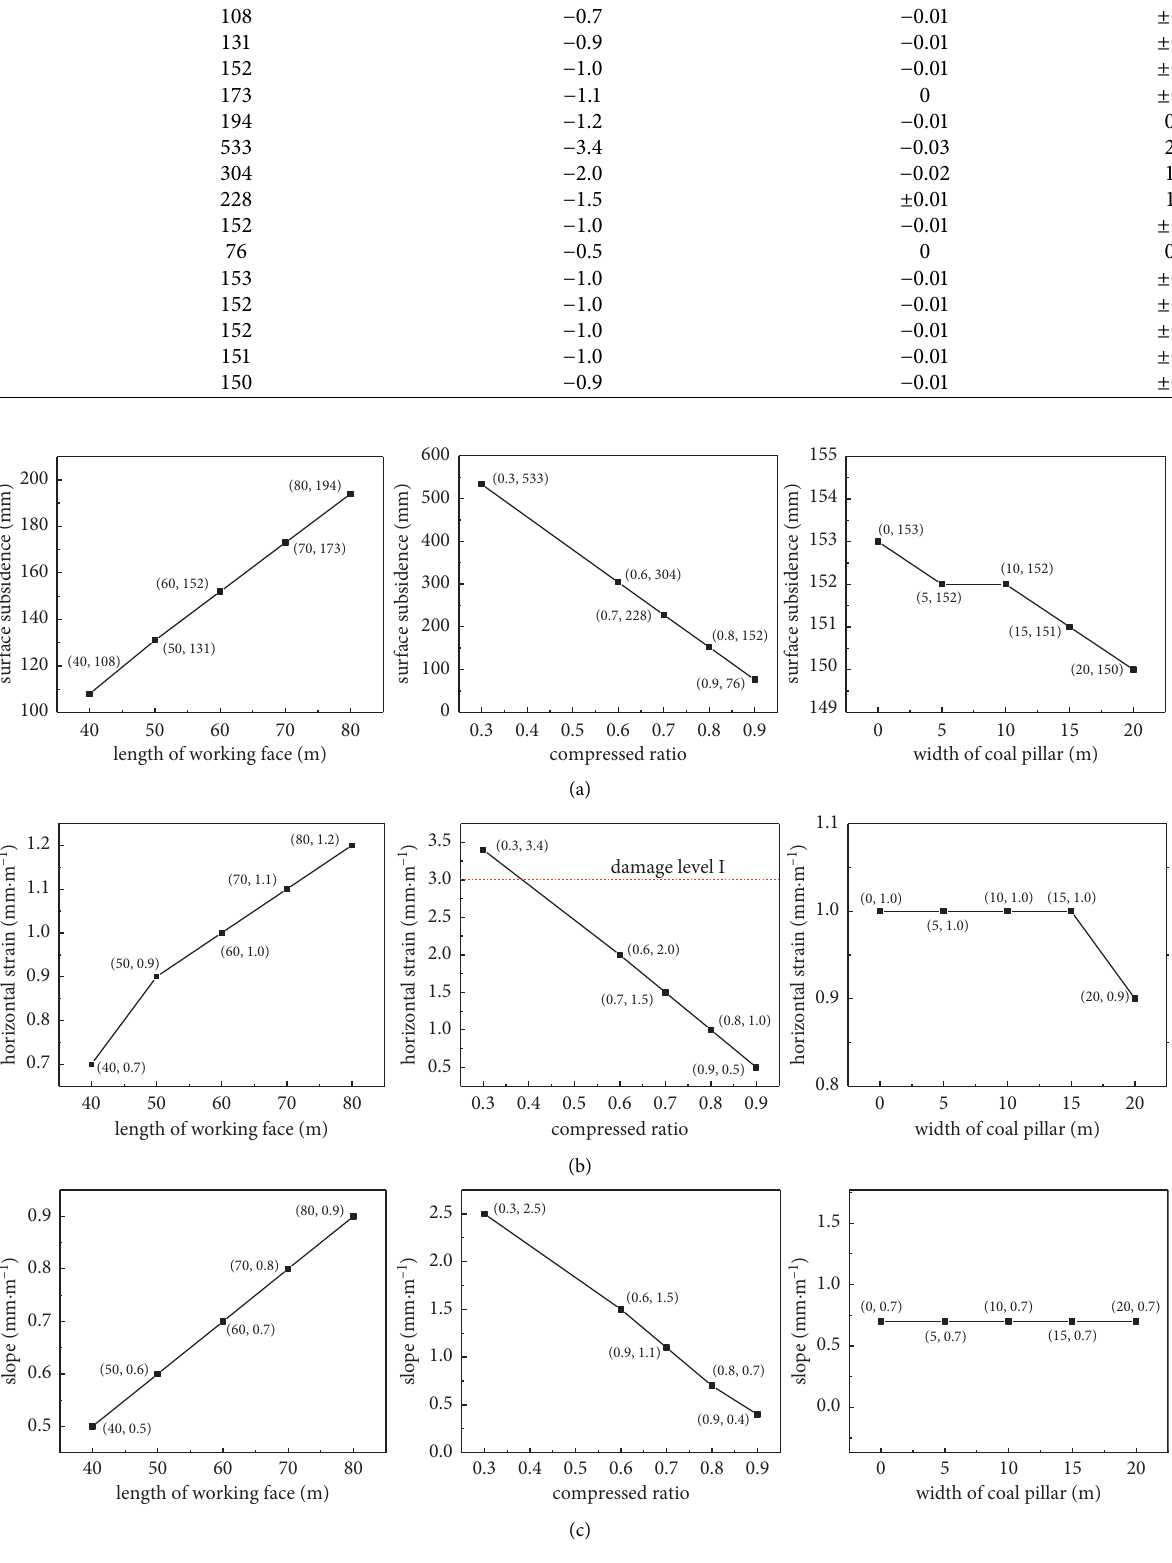
Figure 10: Experimental results: (a) surface subsidence values, (b) horizontal deformation, and (c)